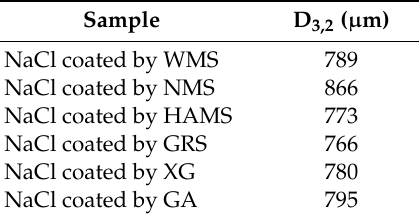
Table 2. Particle size distribution of NaCl-coated microparticles (sieving mesh sizes no. 100) a .